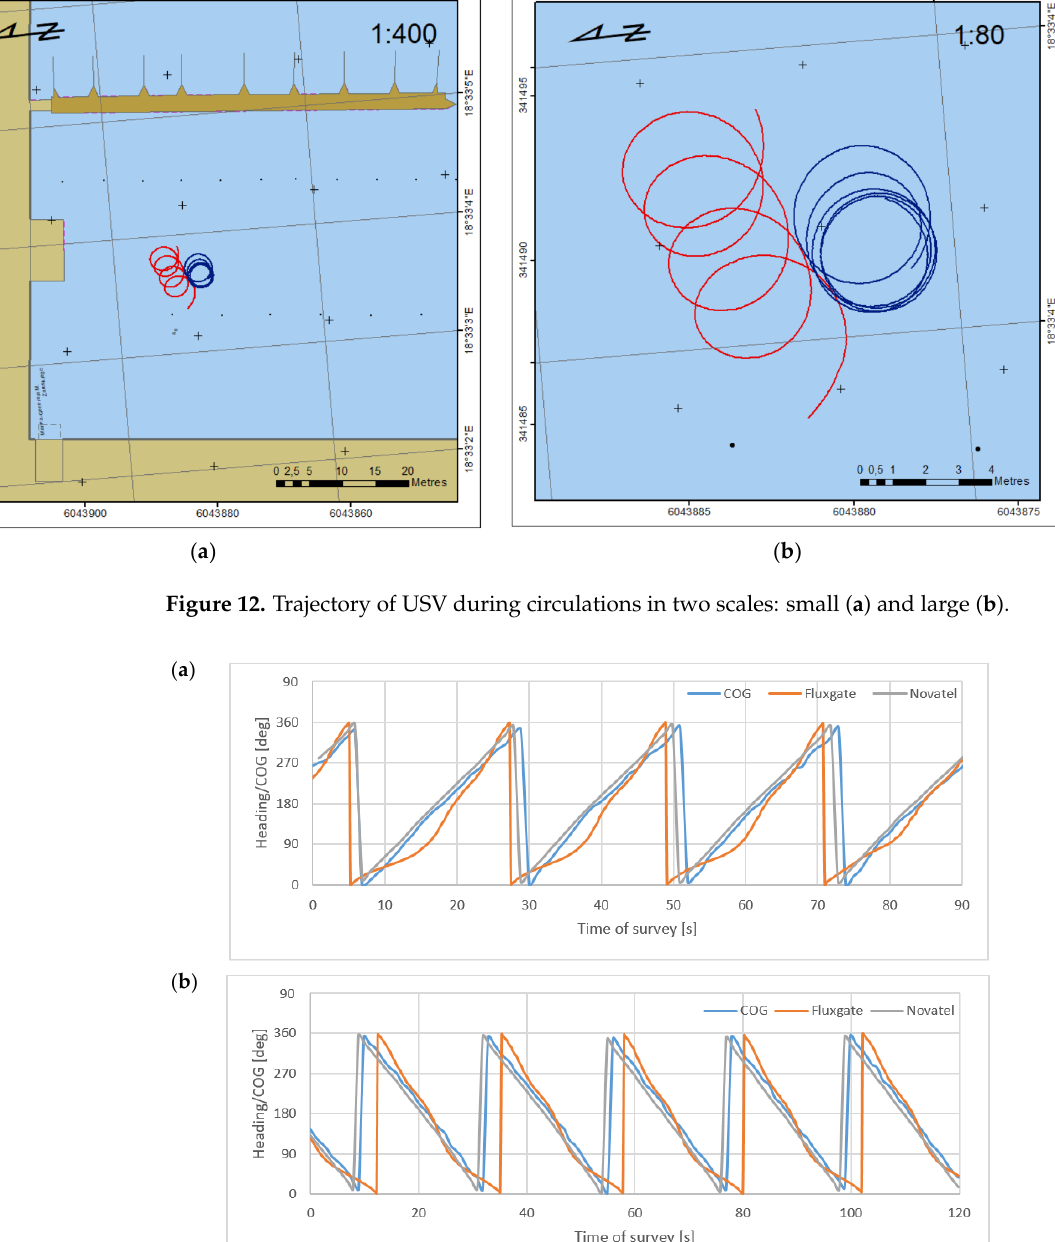
Figure 13. Headings and COG during 90 s rotation of the USV to the right ( a ) and 120 s rotation to the left ( b ).